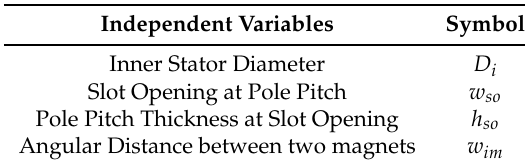
Table 4. Variables.